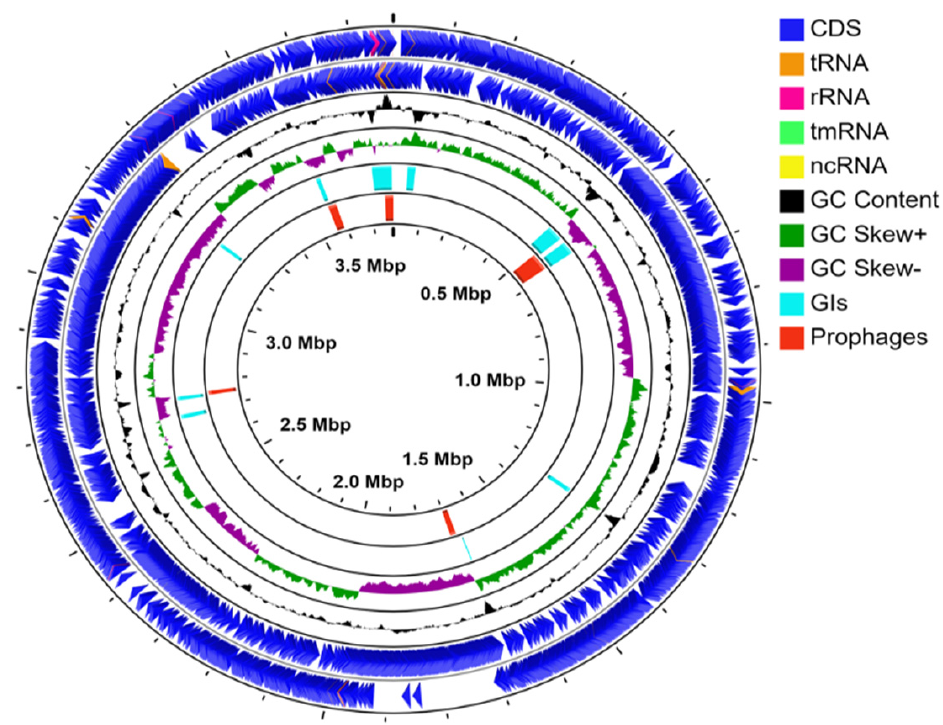
Figure 1. Circular visualization of B. pumilus strain SF-4 genome. Circle from outside to inside represent the position of protein-coding genes (CDS), tRNA, rRNA genes on the positive (circle 1) and negative strands (circle 2). Circle 3 (green and purple) and 4 (Black) show GC skew and GC content plotted as the deviation from the average for the complete genome. Circle 5 and 6 represent the genomic position of putative GIs (light blue) and prophages (red), respectively.